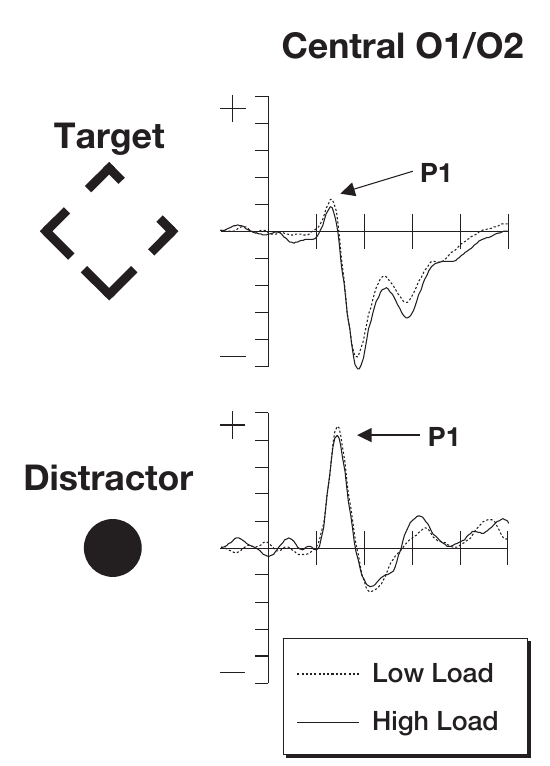
Figure 2. The P1 components from this study. Note that numerically the P1 is stronger during periods of low perceptual load (dotted line) than periods of high perceptual load (solid line). This effect is found both for targets as well as irrelevant distractor items. The top row of plots shows ERPs to the target stimuli where the participant was expected to make a gap judgment. The lower row shows ERPs to the irrelevant but salient central distractor stimuli. The horizontal axis shows time, beginning 100 ms prior to stimulus onset and continuing until 500 ms after onset, while the vertical axis shows the voltage (with a range from + 5 to − 5 µV). The solid line represents the ERP during periods of high perceptual load while the dotted line shows responses during sequences of low perceptual